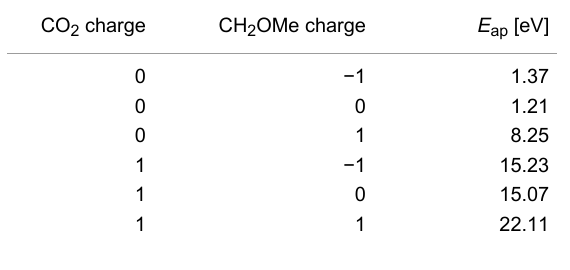
Table 2: Appearance energy (Equation 2) of differently charged O 2 C and CH 2 OMe fragments from dissociation of O 2 CCH 2 OMe − .